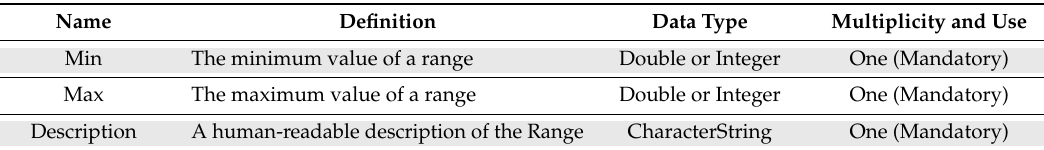
Table 7. Properties of the Range